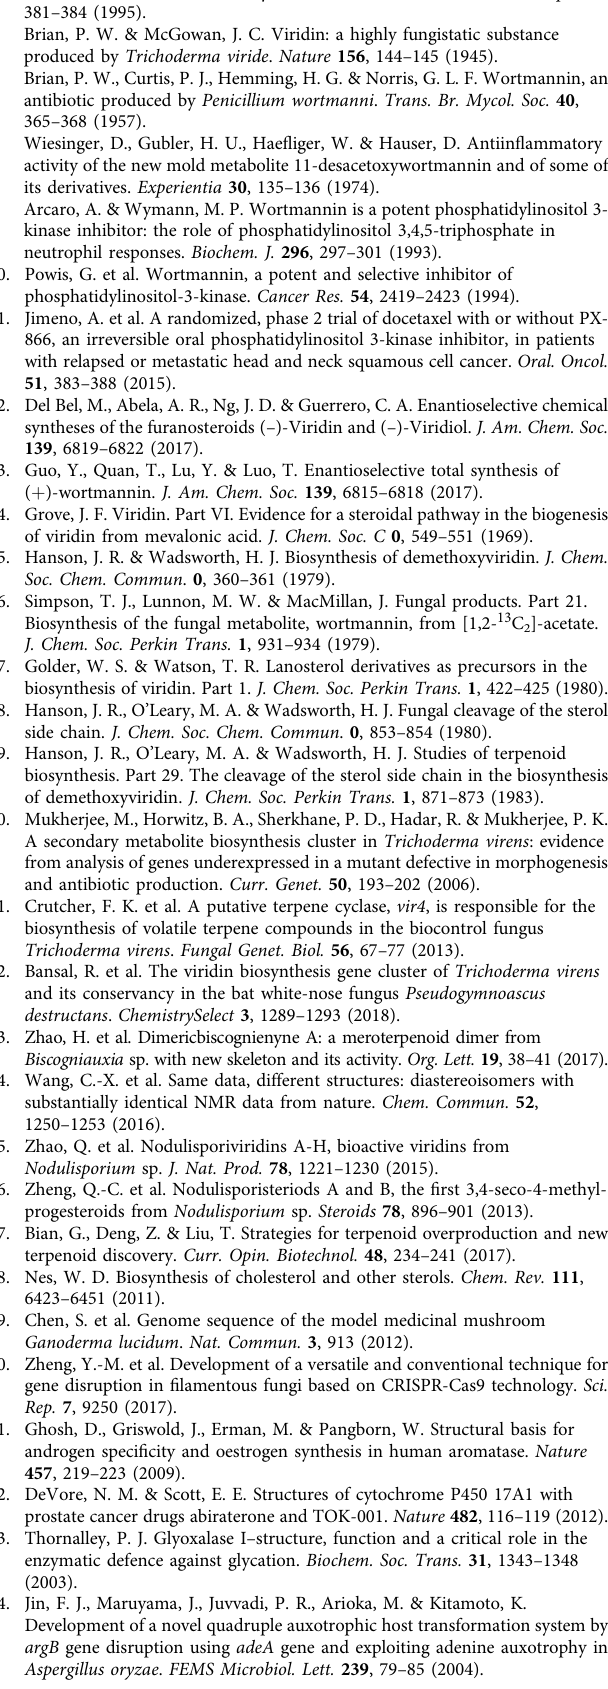
Data availability . The sequence data for the vid gene have been deposited at GenBank under accession MG886384. The crystallographic data of small-molecule compounds related to this manuscript have been deposited at the Cambridge Crystallographic Data Center: CCDC 1821761 − 1821763. All relevant data are available from the corresponding authors on